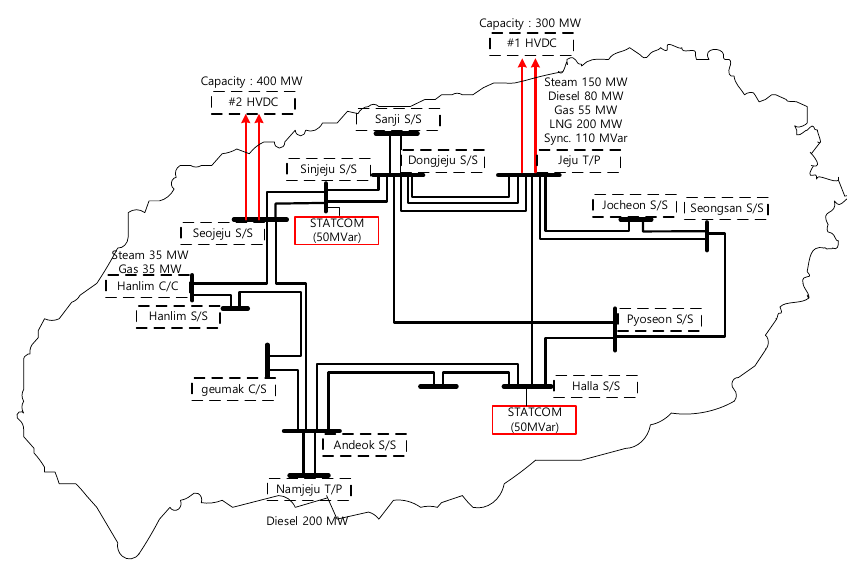
Figure 1. Jeju Island power system.